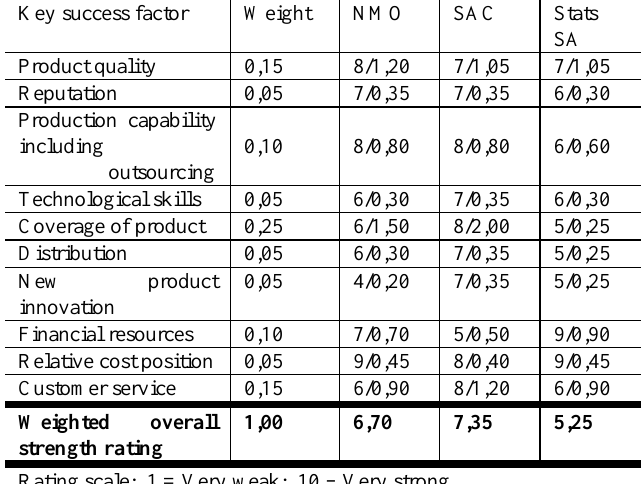
Table 3: Weighted competitive strength assessment of public sector